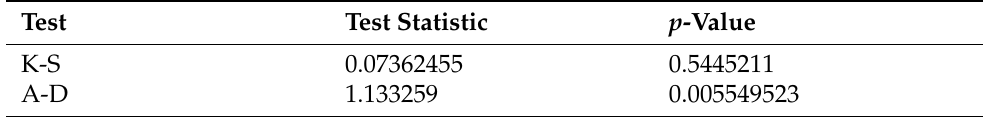
Table 12. Goodness-of-fit for Limpopo